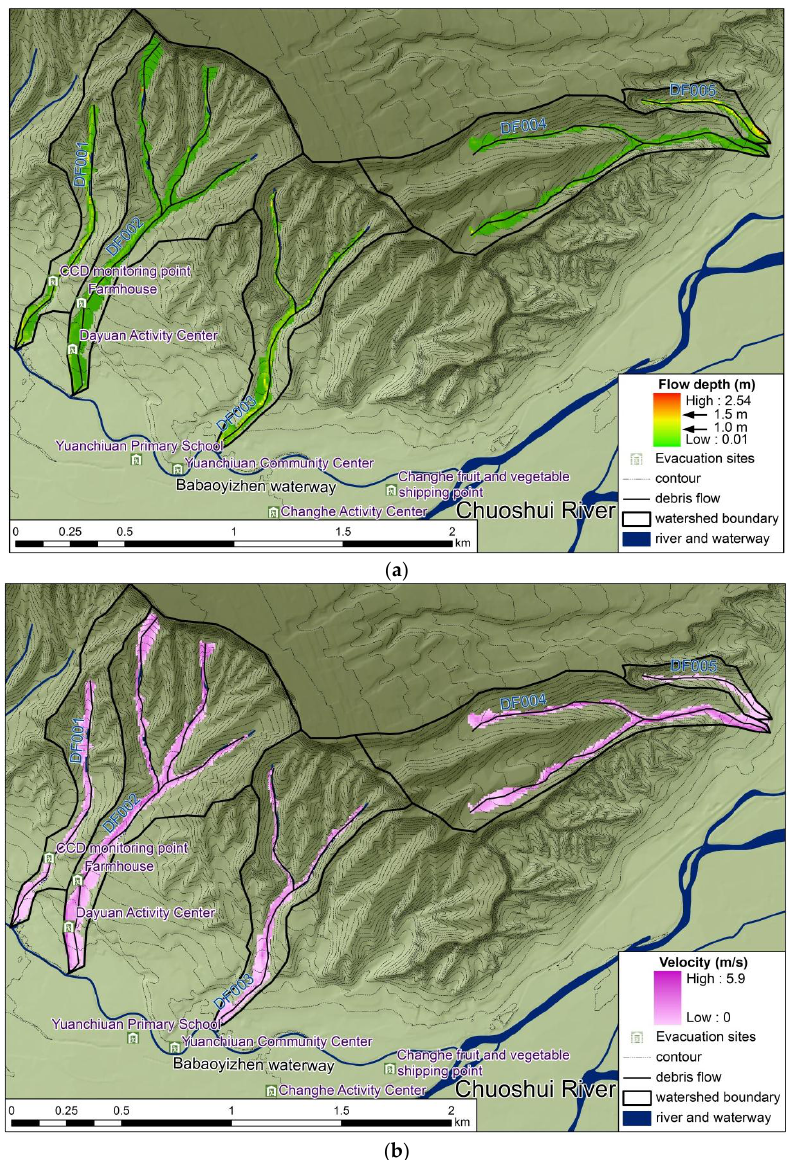
Figure 8. FLO-2D simulation result. ( a ) Simulation of maximal flow depth; ( b ) simulation of maximal flow velocity.